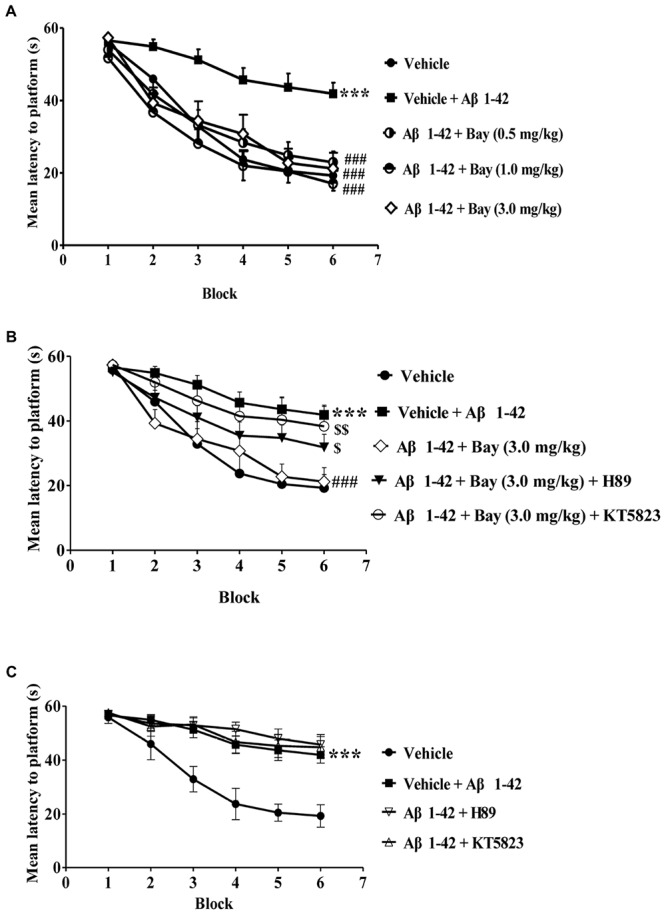
Learning curve in the water maze task after treatment with BAY 60-7550. (A–C) During the acquisition trials of the water maze task, the learning curve was tested 24 h after last treatment with Bay 60-7550. Values shown are means ± SEM, n = 10; ∗∗∗p < 0.001 vs. vehicle-treated sham group. ###p < 0.001 vs. vehicle-treated Aβ group. $p < 0.05 and $$p < 0.01 vs. Bay 60-7550 (3.0 mg/kg)-treated Aβ1–42 group.